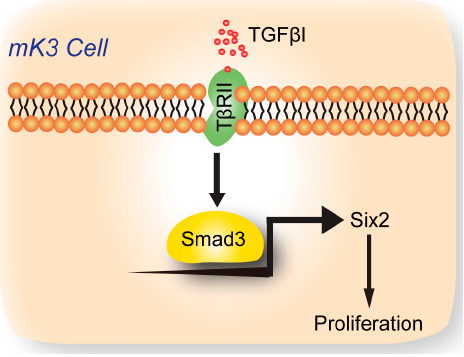
Figure 5. A schematic diagram of the molecular mechanism that T β RII promotes the proliferation of metanephric mesenchyme (MM) cells.